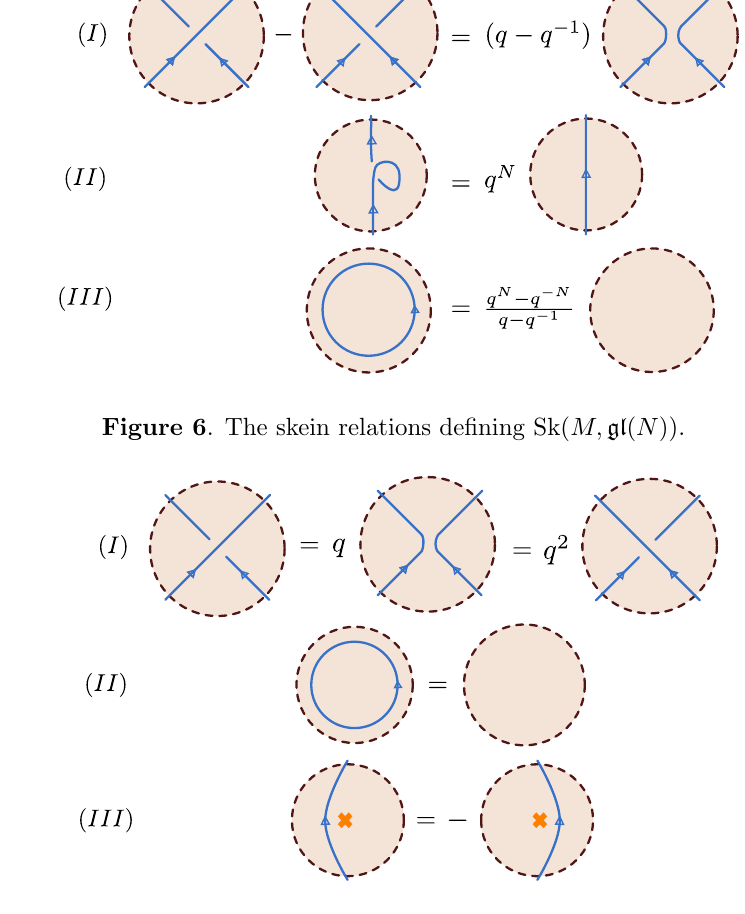
Figure 7 . The skein relations de(cid:12)ning Sk( f M; gl (1)).